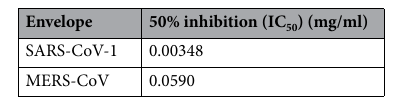
Table 4. IC 50 values of PHELA inhibition of SARS-CoV and MERS-CoV.